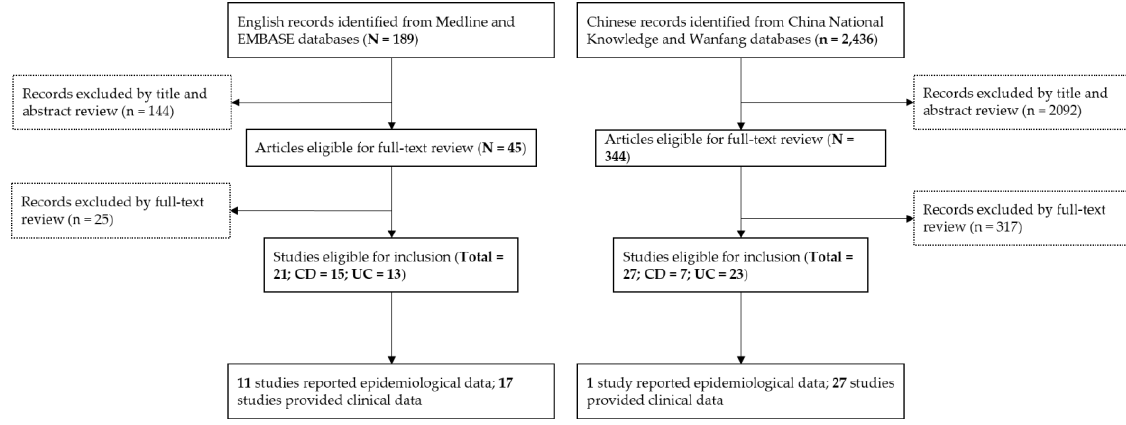
Figure 1. PRISMA flow diagram for literature review.